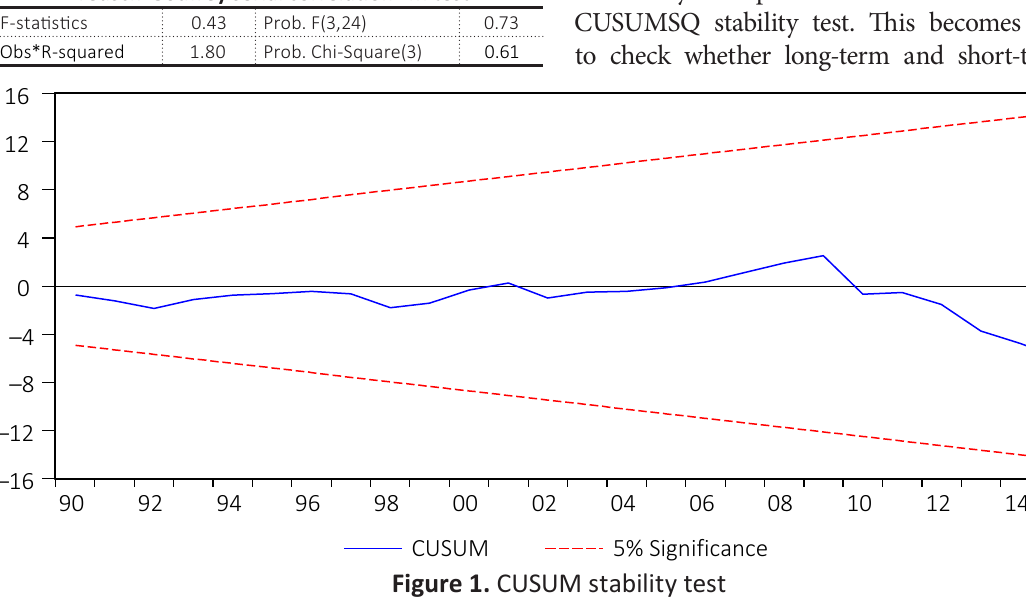
Figure 1. CUSUM stability